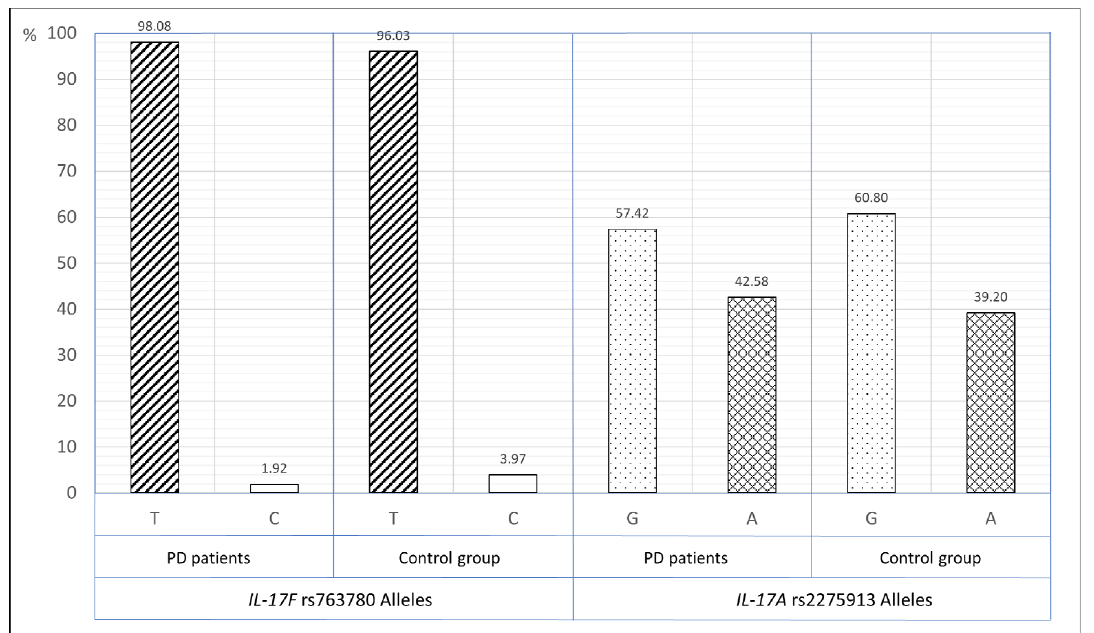
Figure 2. The distribution of IL-17F rs763780 and IL-17A rs2275913 alleles in periodontitis patients and control group in non-smokers group.